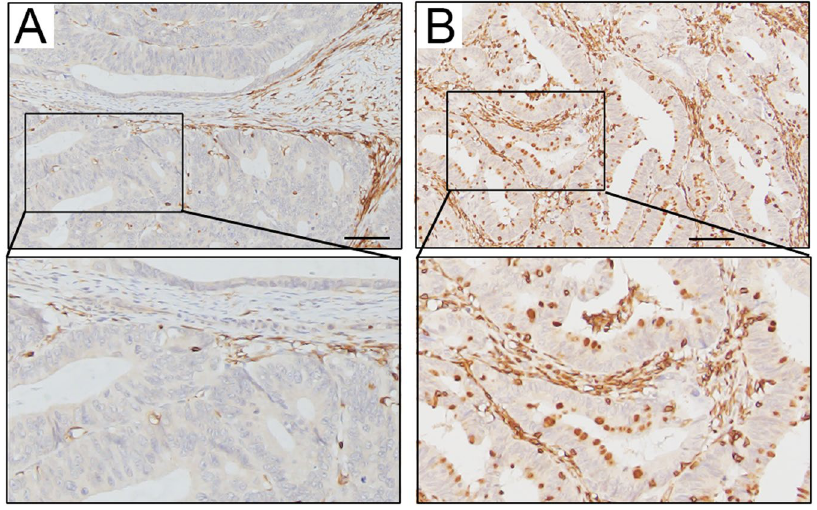
Figure 2. Intra-tumoral CD8 + TILs within the tumor microenvironment of colon carcinoma. ( A ) Low intra- tumoral CD8 + TILs immunohistochemical staining within the tumor microenvironment. ( B ) High intra- tumoral CD8 + TILs immunohistochemical staining within the tumor